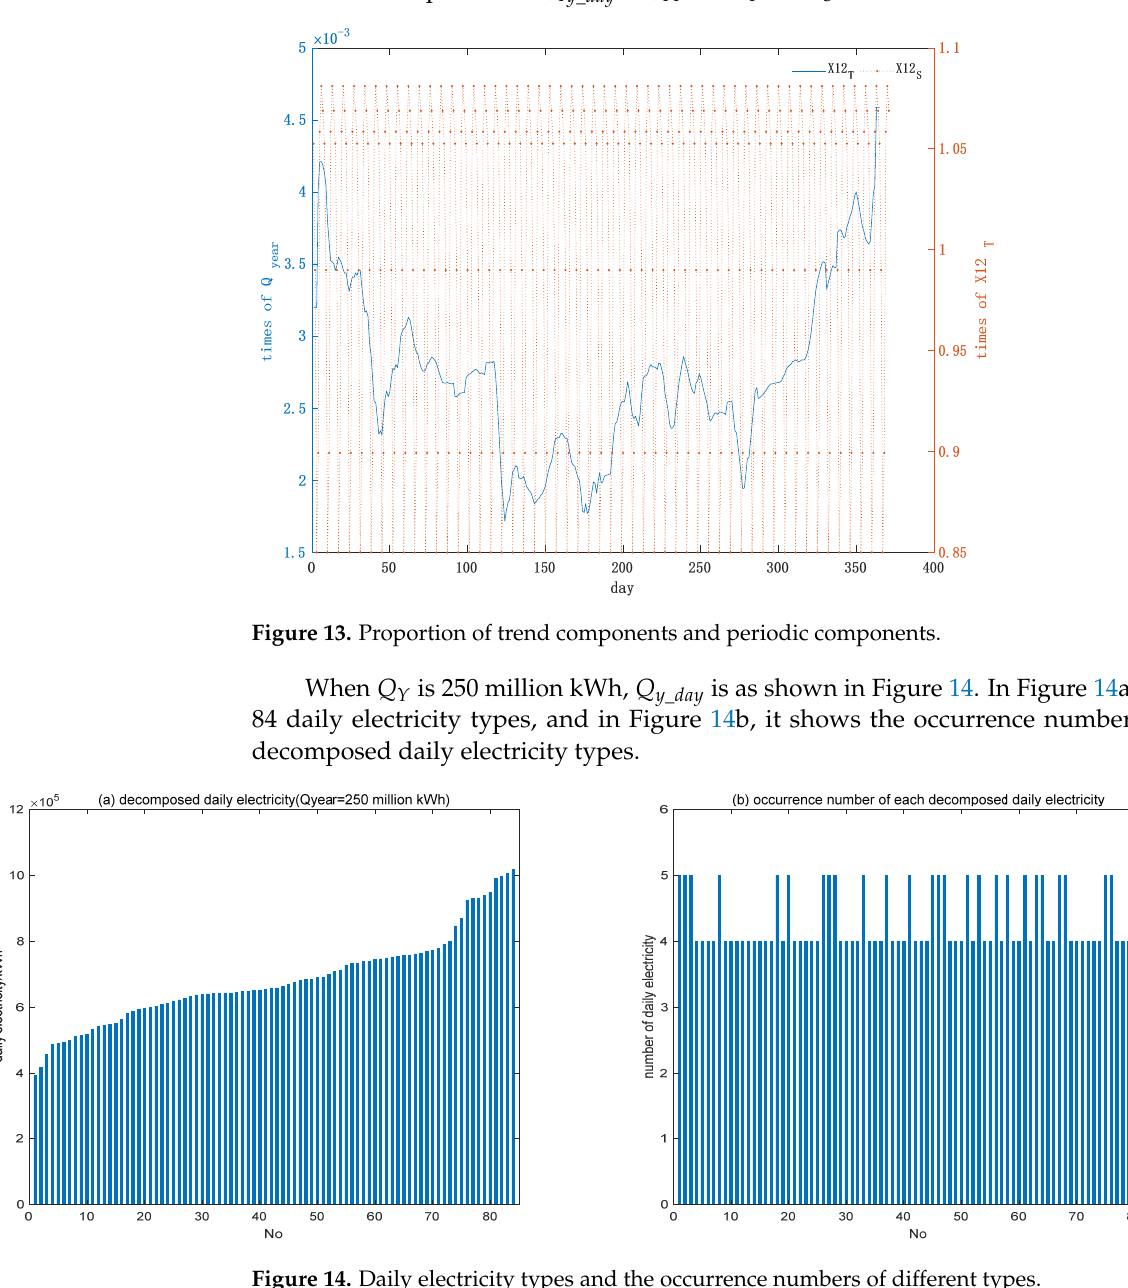
Figure 12. Daily electricity consumption data of charging station operators.